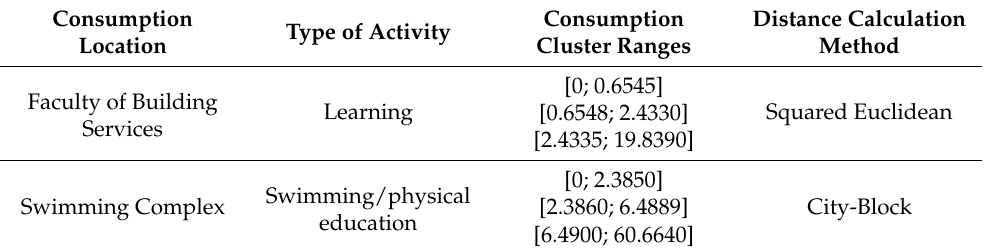
Table 2. The clustering performance.